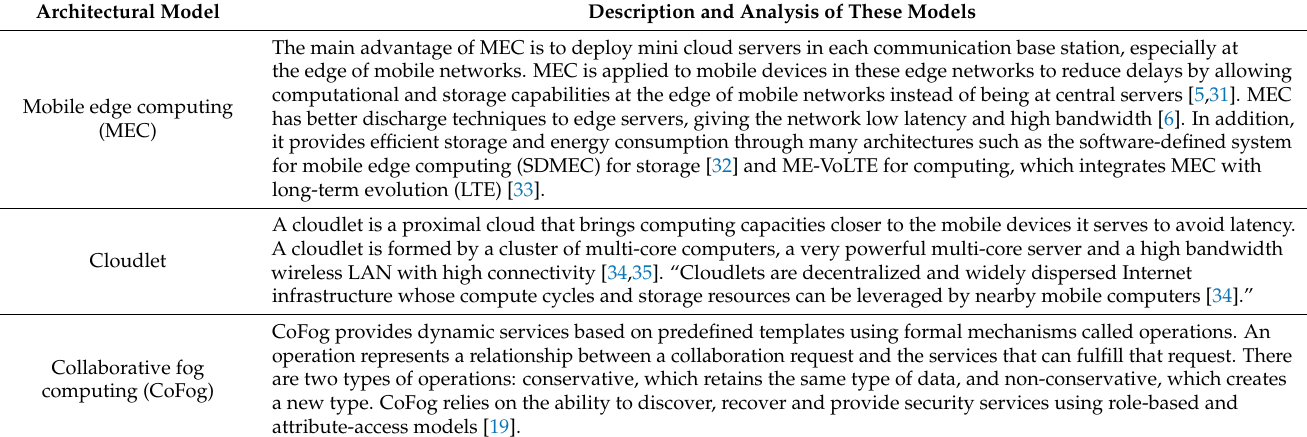
Table 1. Classification of contemporary architectural